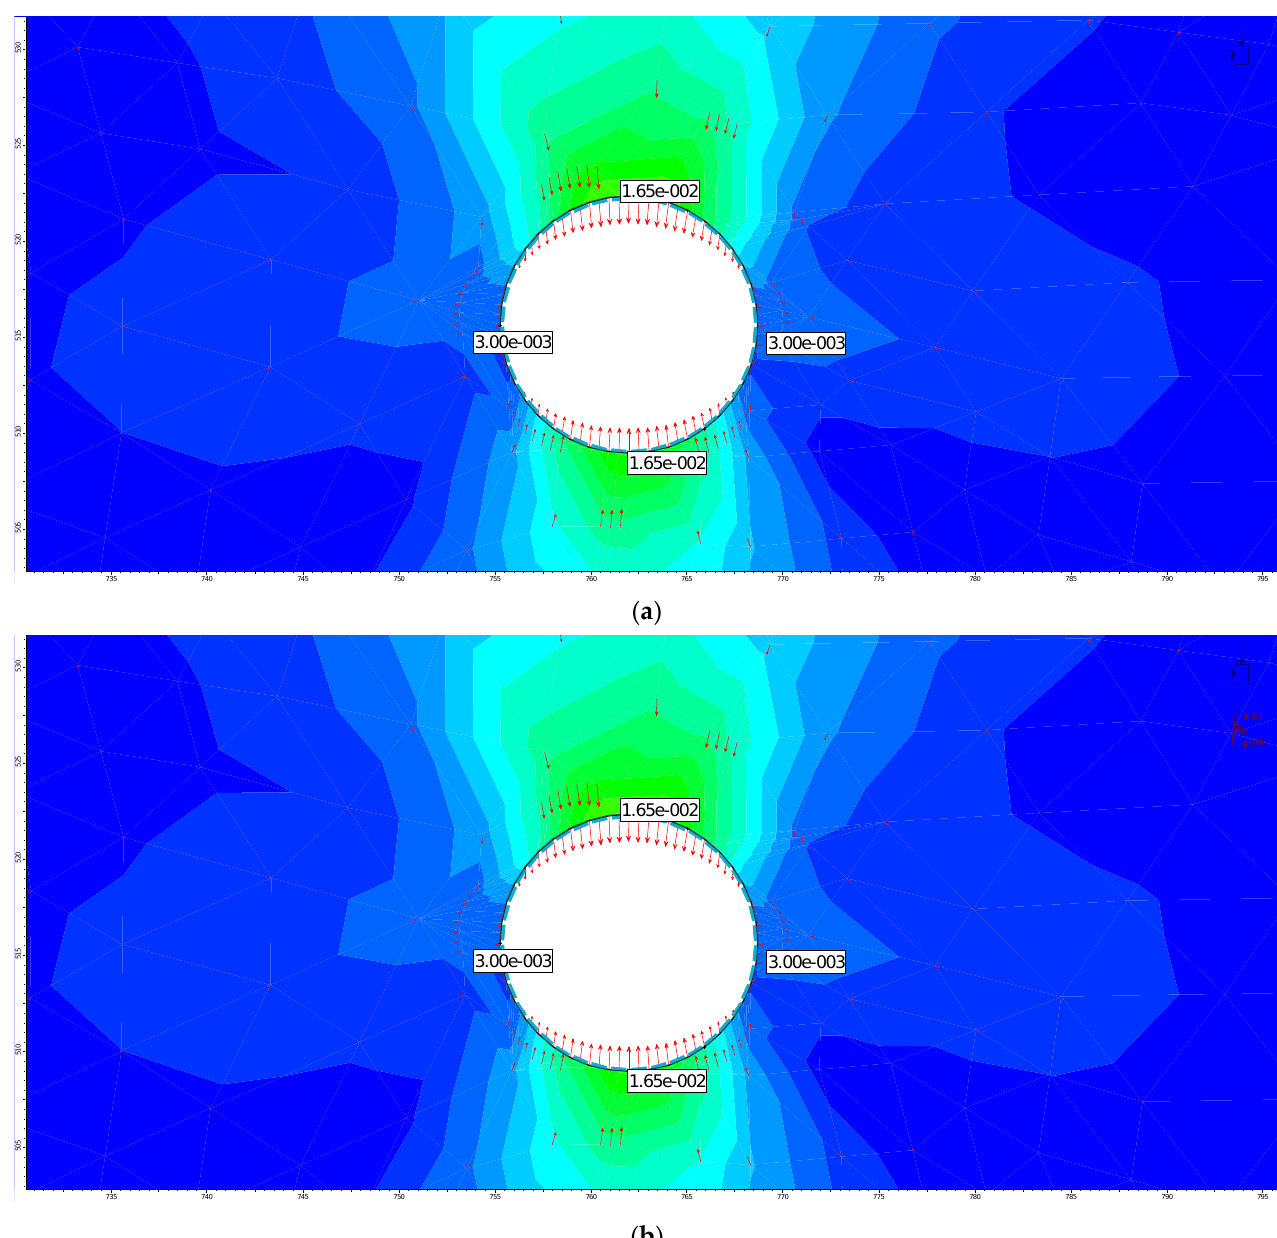
Figure 21. Total displacements obtained from the 2D numerical analysis ( a ) and total displacements obtained from the 2D numerical analysis (seismic conditions) ( b ). (units in m).